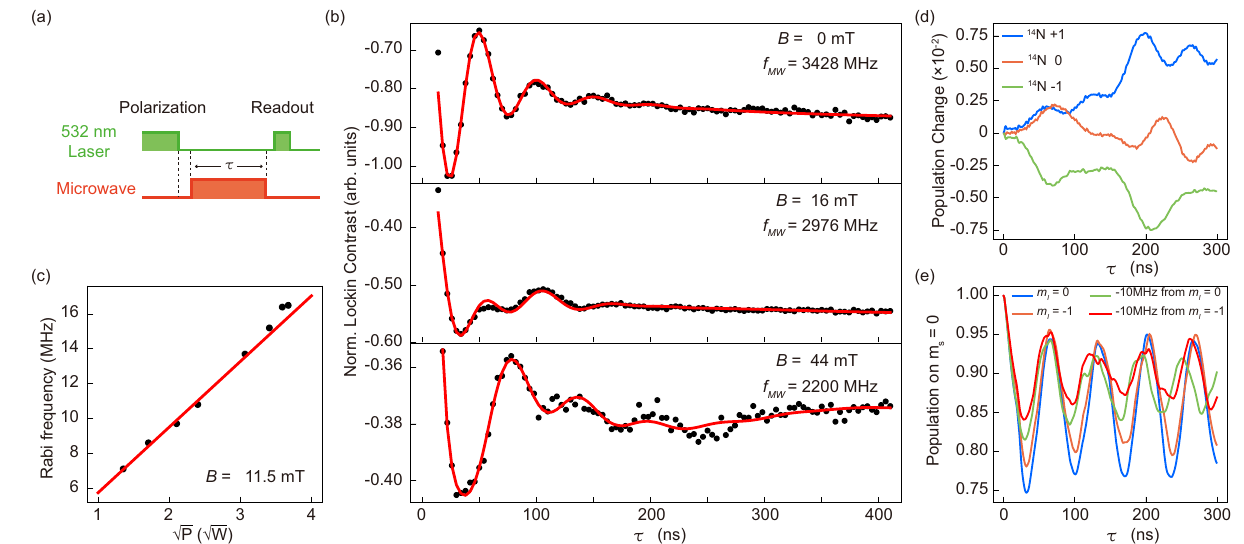
Fig. 2 | Rabi oscillations. a Pulse sequence of Rabi measurement comprising of a constant background, respectively. c Linear dependence of Rabi frequency on the ffiffiffi p fi rst laser pulse for spinpolarization, thena microwavepulse with length τ for spin square root of microwave power . d Theoretical dynamical oscillation of 14 N P nuclearspinswiththedrivingMWresonantatthe m I = − 1hyper fi nepeak.Theblue, manipulation, and fi nally a second laser pulse for state readout. b Room- temperature Rabi oscillations on the m s = − 1 ↔ m s =0 transition observed at dif- orange, and green curves show the dynamical polarization changes on the m I =+1, ferent magnetic fi elds of B =0 mT (top), B =16 mT (middle) and B =44 mT (bot- 0, and − 1 nuclear spin states under continuous MW driving, respectively. Q n ð 2 π f τ + ϕ Þ + be (cid:1) τ = T b + c with the e TheoreticalRabioscillationof the4-spinV (cid:1) B system.Theblue,orange,green,and tom). The data are fi tted using ae (cid:1) τ = T a i i i =1 cos amount of the different oscillation components are chosen empirically as n =1 for red curves show Rabi oscillations driven by the MW with frequencies at center B =0 mT, n =2 for B =16 mT, and n =3 for B =44 mT (red curves). The fi tting peak, and -10MHz detuning from m I = − 1 hyper fi ne peak, parameters a , T a , f i , ϕ i , b , T b and c are oscillation amplitude, oscillation decay time, frequency, phase, background decay amplitude, background decay time, and